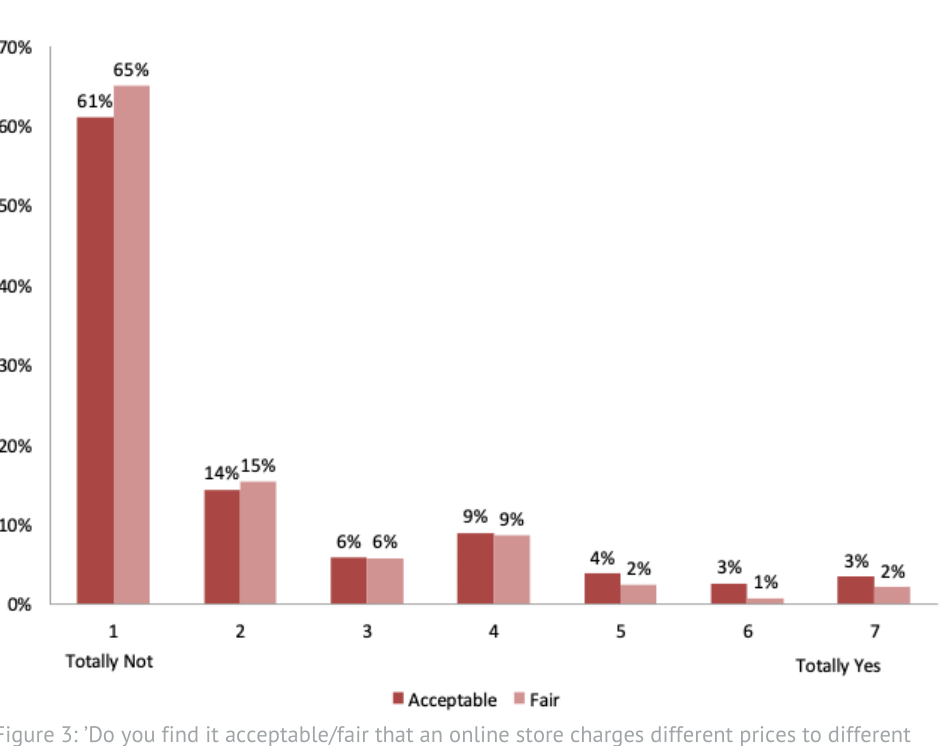
Figure 2: ’According to you, should such practices be prohibited?’ (N=1233)